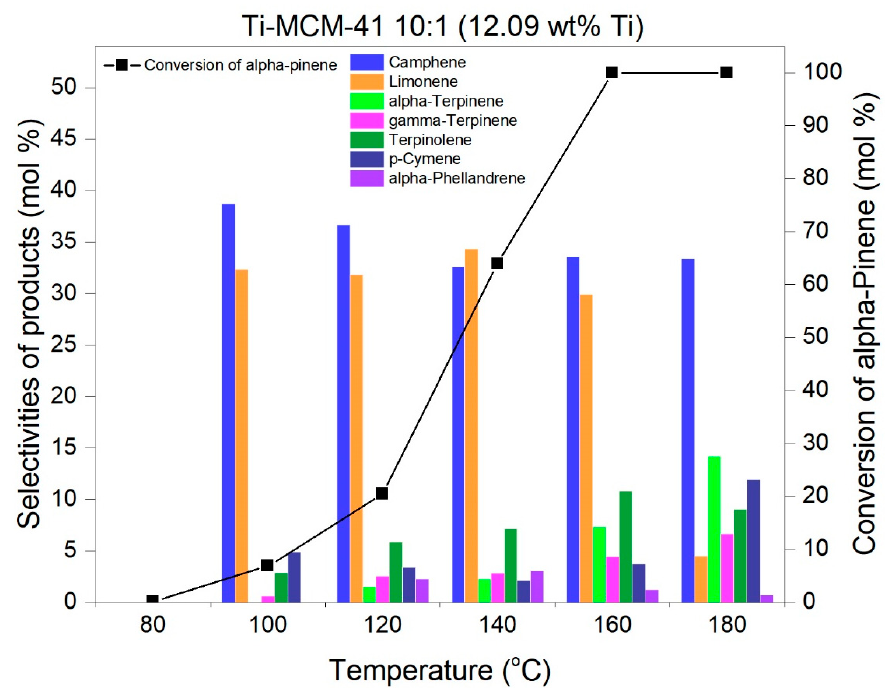
Figure 10. The influence of temperature on the conversion of α -pinene and on the product selectivity over Ti-MCM-41 10:1 (catalyst content 7.5 wt% relative to α -pinene, reaction time 7 h).